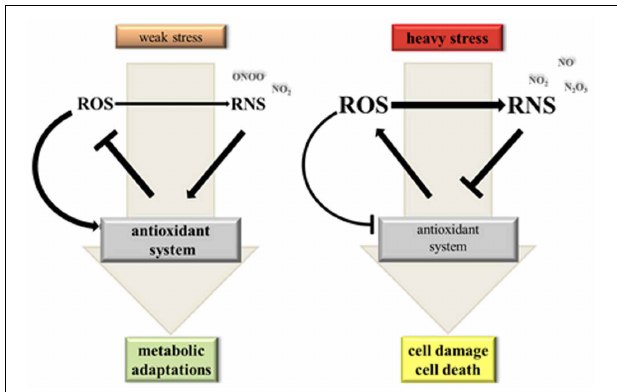
FIGURE 2 | Hypothetical model on the dynamic interaction between NO, ROS and the antioxidant system under stress conditions. Weak stress triggers a moderate elevation of ROS (reactive oxygen species) and NO levels. ROS act as signals inducing NO synthesis and activation of the antioxidant system for improved metabolic adaptation. If ROS is produced at a somewhat higher rate than NO there would be mainly formation of oxidizing and nitrating RNS (reactive nitrogen species) imposing a weak oxidative stress to the cell. Heavy stress leads to a strong ROS and RNS burst. High NO levels promote formation of N 2 O 3 from NO 2 and NO and consequently nitrosative stress. Under these conditions ROS and RNS inhibit the antoxidant system causing damage and ultimately death of plant